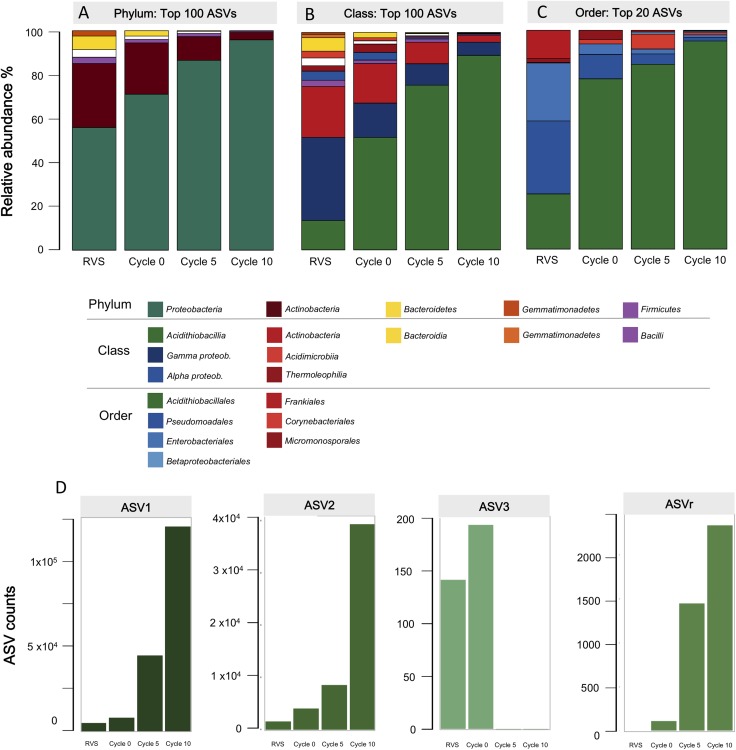
Taxonomic profiles and proportions of the RVS microbial consortium during adaptation cycles to the RGC. (A) Phylum level, top 100 ASVs; (B) Class level, top 100 ASVs; (C) Order level, top 20 ASvs. (D) Absolute abundance of the ASVs ascribed to the dominant taxon (Acidithiobacillia): ASV1 (184,713 total reads); ASV2 (51,844 total reads); ASV3 (191 total reads); ASVr (3,890 total remaining reads).